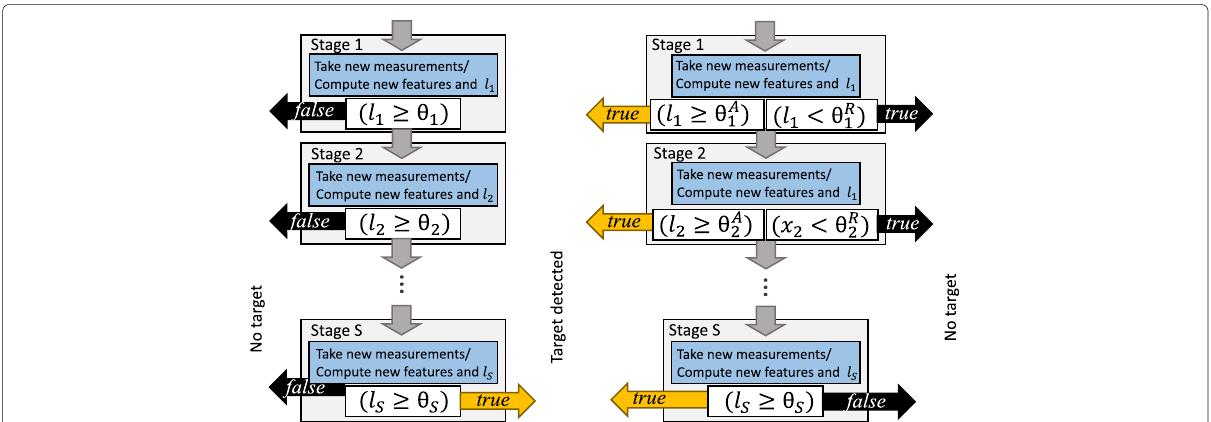
Fig. 1 Two types of binary classification cascades. Typical object detection cascades utilized in computer vision. Left: an asymmetrical type cascade for classifying efficiently the “non-target” windows. Right: a symmetrical detection cascade which is capable of early classification to both